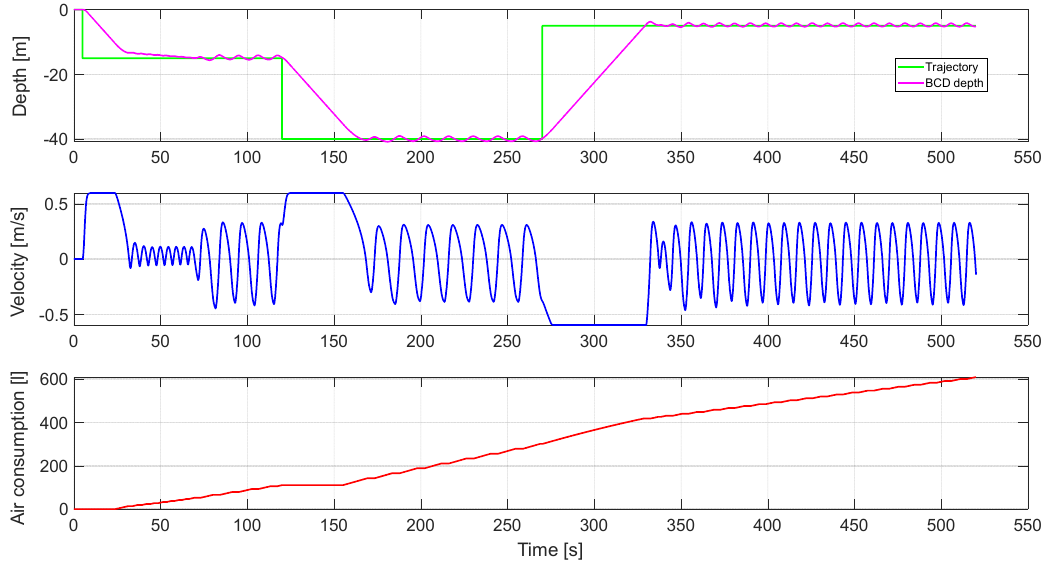
Figure 7. Control response obtained after the optimization process with the position FCLS.